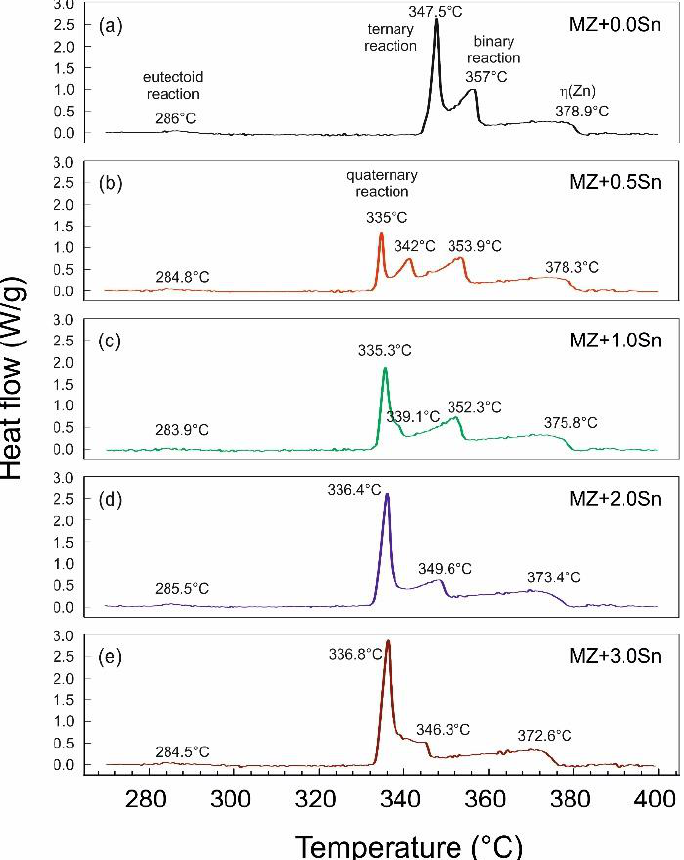
Figure 1. Comparison of the DSC curves for all investigated alloys. Hence, the individual microstructure features in the as-cast samples cannot be clearly distinguished; the DSC samples after the cooling run were investigated via SEM. These observations enabled us to identify the individual reactions for each recorded peak. Peaks were recorded describe the reactions of the following phases: η (Zn)–hcp Zn- based solid solution; γ (Al)–fcc Al-based solid solution present above the eutectoid reaction temperature reported at 275 ◦ C in the Zn-Al system [37] up to melting temperature; α (Al)– fcc Al-based solid solution present below the Zn-Al system eutectoid reaction; Mg 2 Zn 11 , MgZn 2 and Mg 2 Sn intermetallic phases of respective systems. The curve in Figure 1a corresponds to the MZ + 0.0Sn alloy. The first peak observed at about 285.0 ◦ C corresponds to the eutectoid transformation α (Al) + η (Zn) → γ (Al). This peak is repeated for all alloys observed. Melting of pure MZ + 0.0Sn starts at 344.0 ◦ C (peak maximum at 347.5 ◦ C) with melting of the ternary eutectic consisting of η (Zn), γ (Al) and Mg 2 Zn 11 phases. An example of such areas is provided in Figure 2a. This is followed by the melting of the Zn/Mg x Zn y binary eutectic (peak maximum at 357.0 ◦ C). A clear example can be observed in Figure 2b. Mg x Zn y corresponds to a mixture of Mg 2 Zn 11 and MgZn 2 phases as documented in Figure 2c. A closer detail of this area is given in Figure 2d) showing also the α (Al) + η (Zn) eutectoid particles in detail. Chemical composition of the individual phases is documented in Table 2. The last peak corresponds with the melting of the Zn rich dendrites (peak maximum at 378.9 ◦ C)